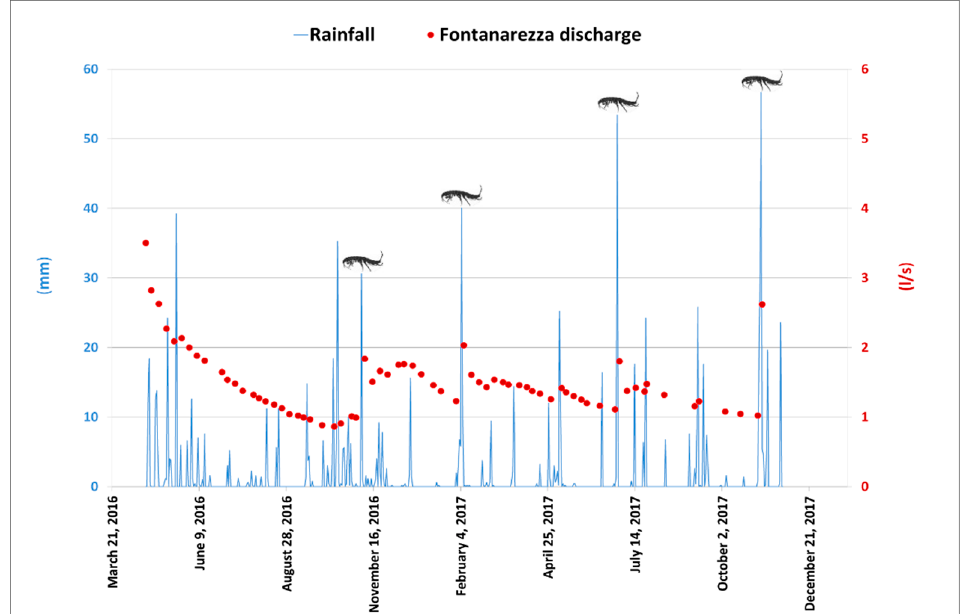
Figure 14. Flow rate (red dotted line), Niphargus occurrences, and precipitation data (blue bar